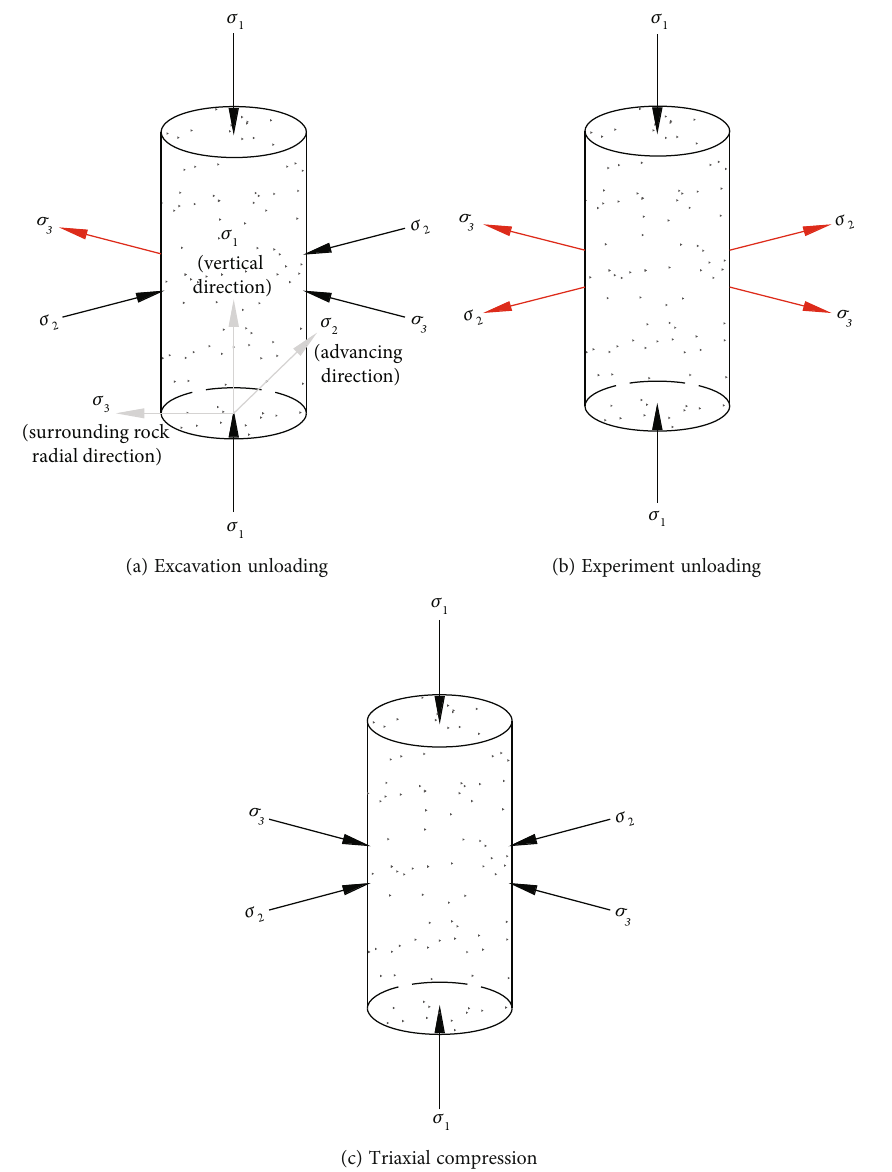
Figure 10: Comparison of excavation unloading and experiment